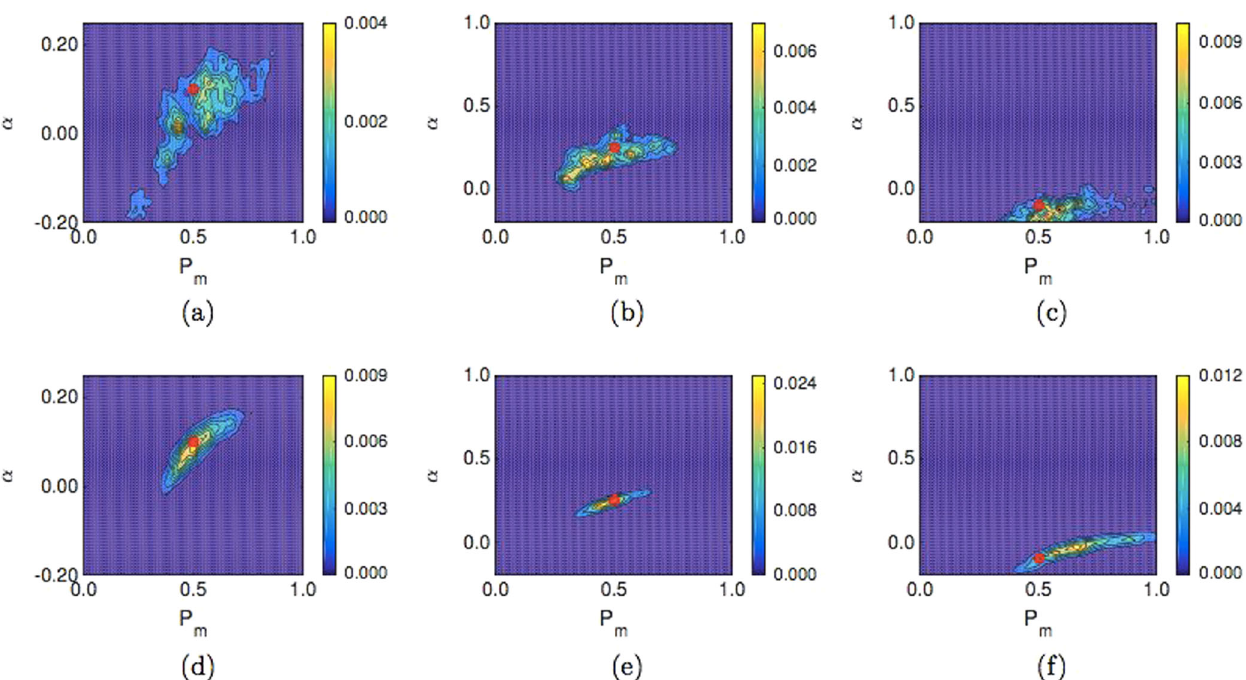
Fig. 6 a – c Posterior distributions for simulations of the realistic experiment using the PCF as a summary statistic for an ABM simulated on a domain of dimension L x = 23 by L y = 23 with synthetic data generated from 500 replicates. a Model A: P m = 0.5, α = 0.1, b model B: P m = 0.5, = 0.5, α = − 0.1. d – f Posterior distribution plots for simulations of the experiment using the PCF as a summary statistic α = 0.25, c model B: P m for an ABM simulated on a domain of size L x = 23 by L y = 184 with synthetic data generated from fi ve replicates. a Model A: P m = 0.5, α = 0.1, b model B: P